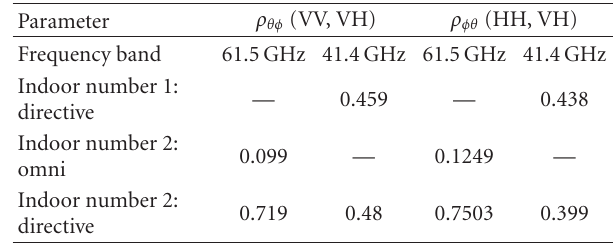
Table 2: Rician K factor for the diversity gain CDFs. Frequency band